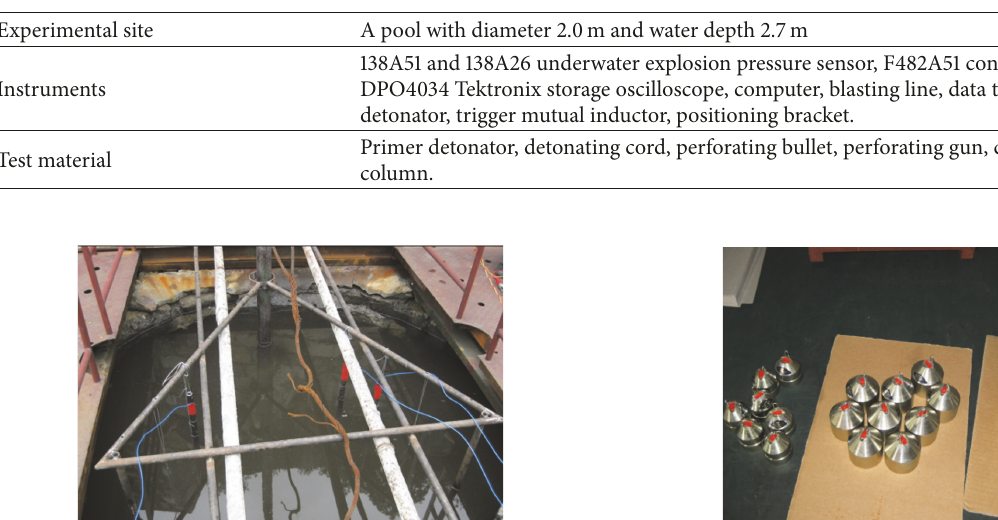
Table 1: Experimental site and equipment.